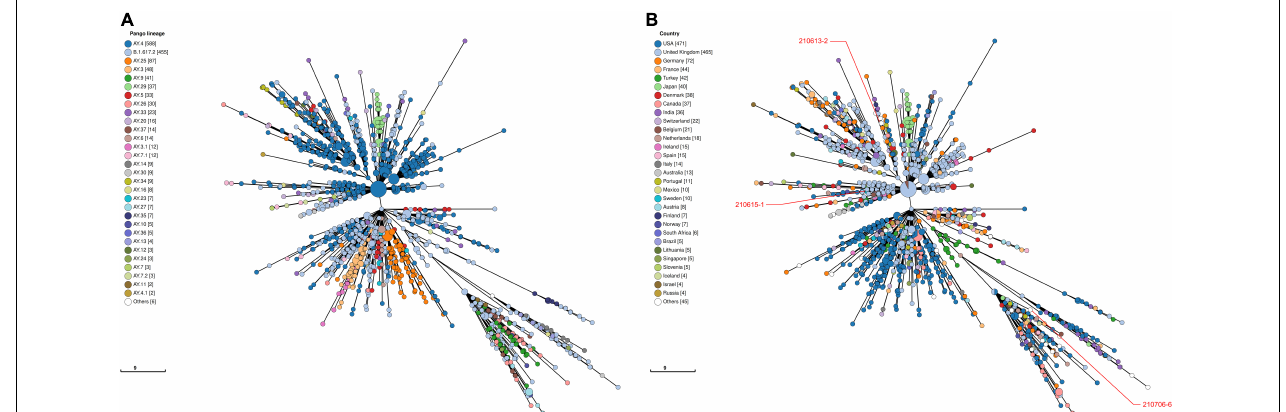
FIGURE 6 | Haplotype network analysis using genome-wide single-nucleotide variations of VOC Delta in the world. The VOC Delta were compared with GISAID-available SARS-CoV-2 genomes ( n = 1,503, updated on October 09, 2021). (A) The Pango lineages of VOC Delta. The lineages are marked with different colors. (B) The countries distribution of VOC Delta. The colors represent different countries. Scale lengths represent the genetic